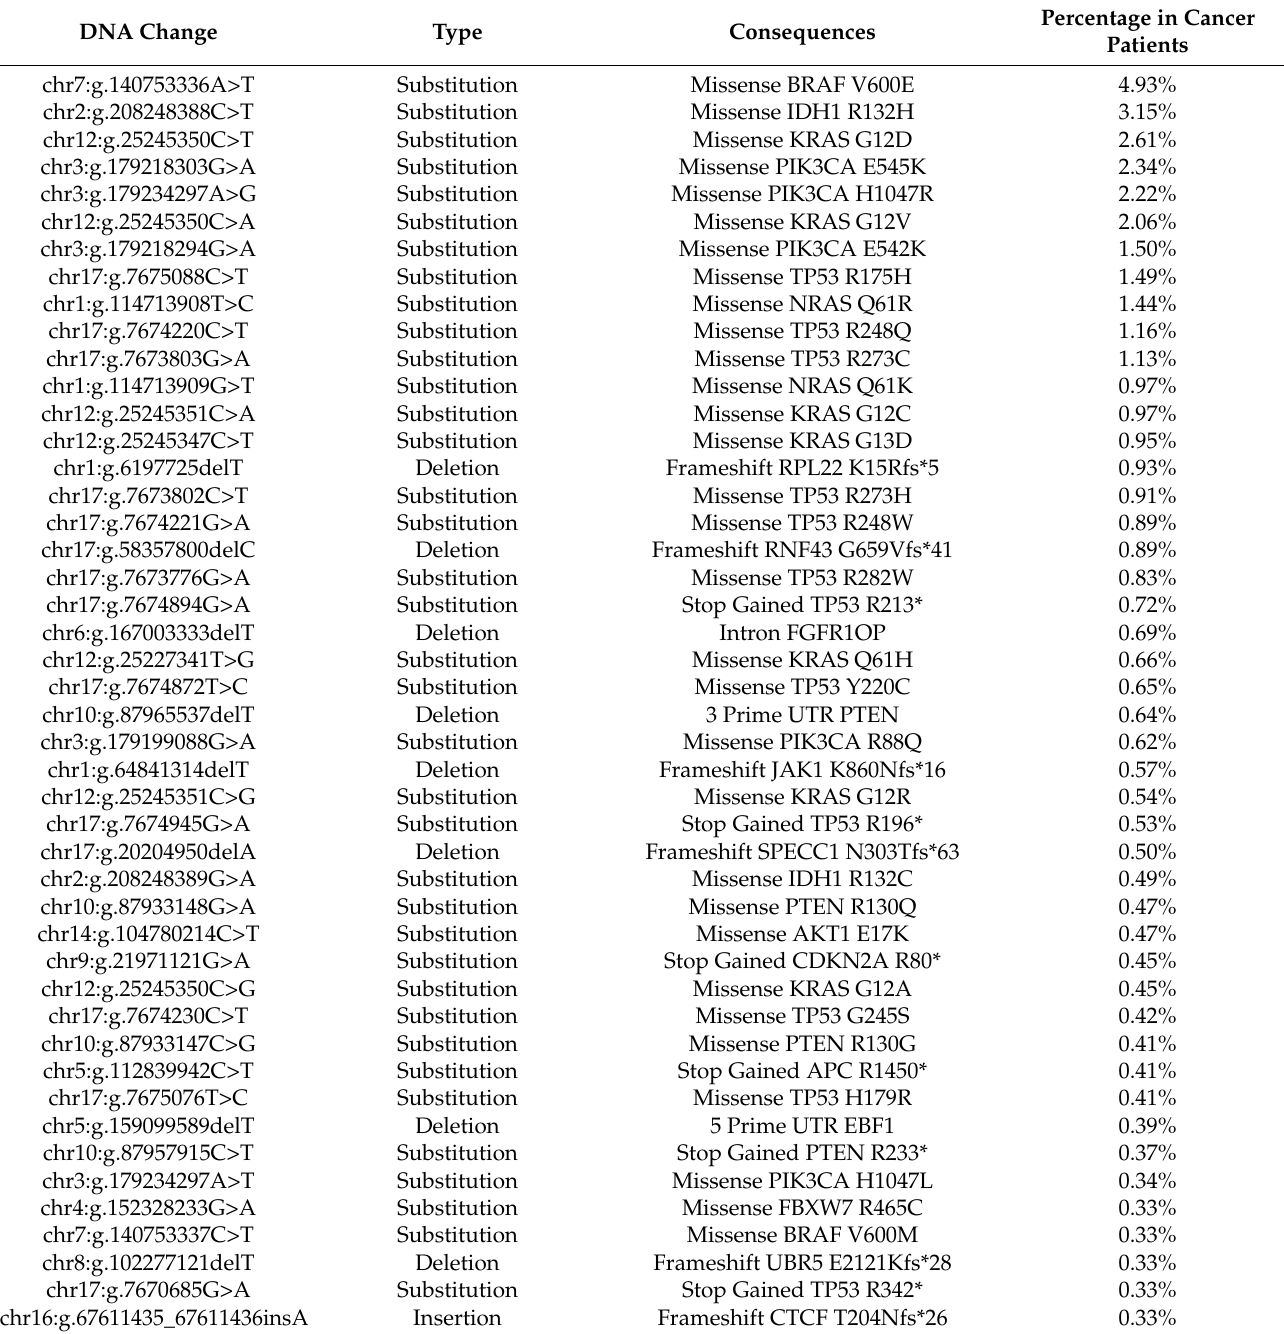
Table 1. Top 100 Cancer Driver